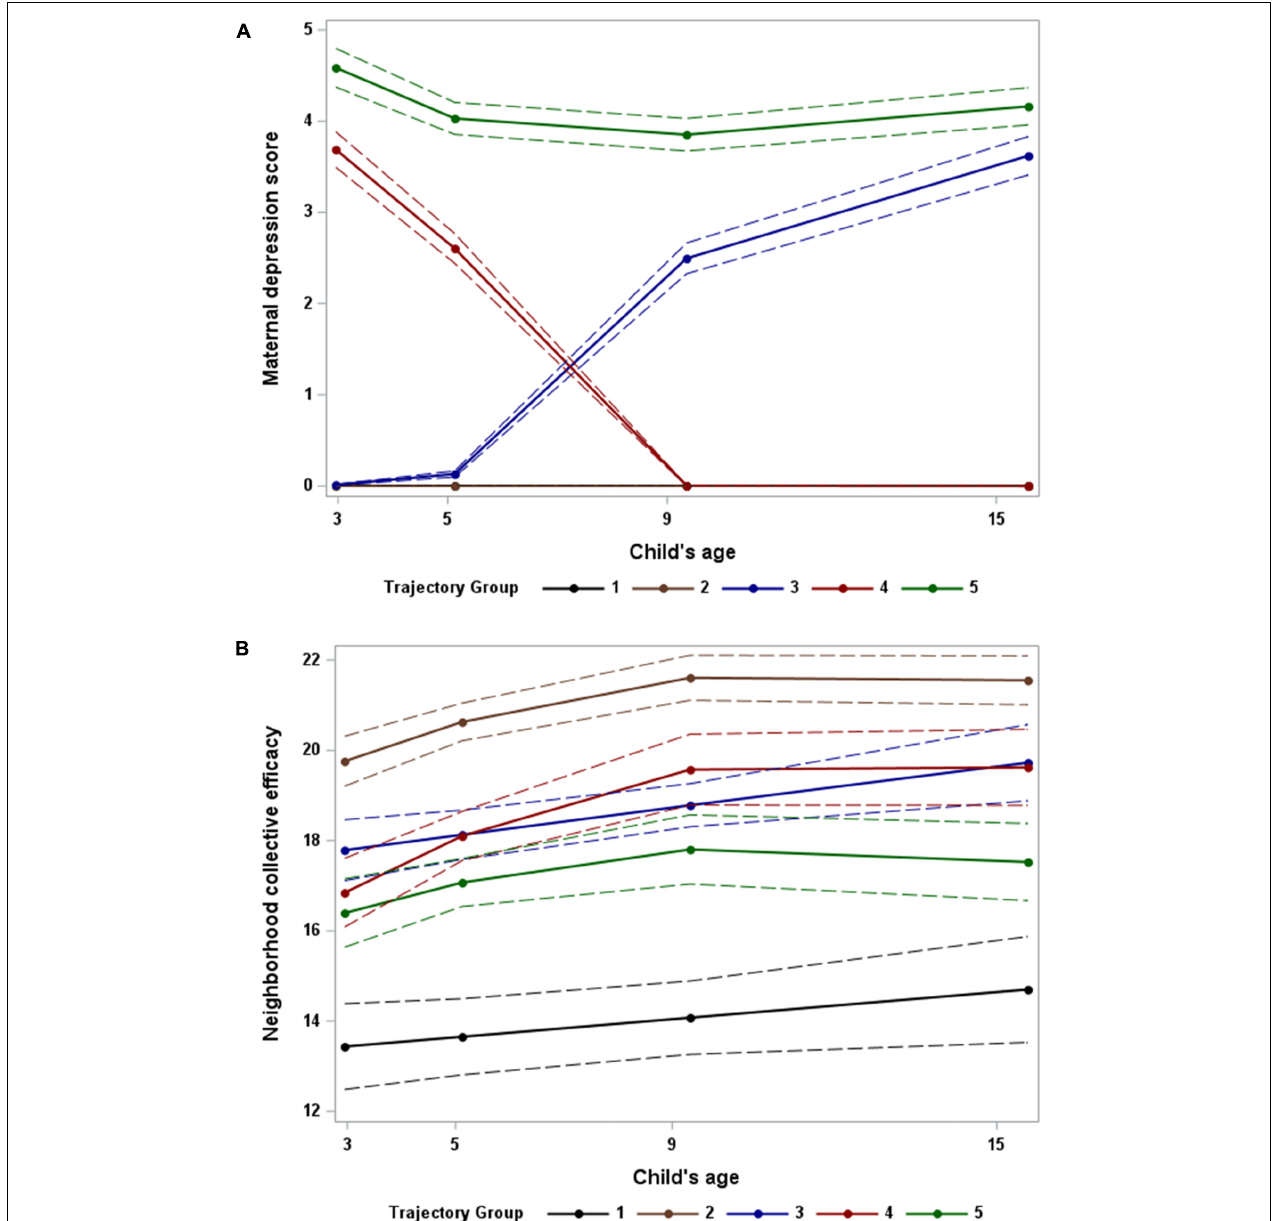
FIGURE 2 | Multi-trajectories of maternal depression (A) and maternal reported neighborhood collective efficacy (B) during the period from when the child is 3 to 15 years of age. Dashed lines reflect 95% confidence intervals for model predictions. Note: Trajectories 1 and 2 in panel (A) both have depression scores of zero at all time